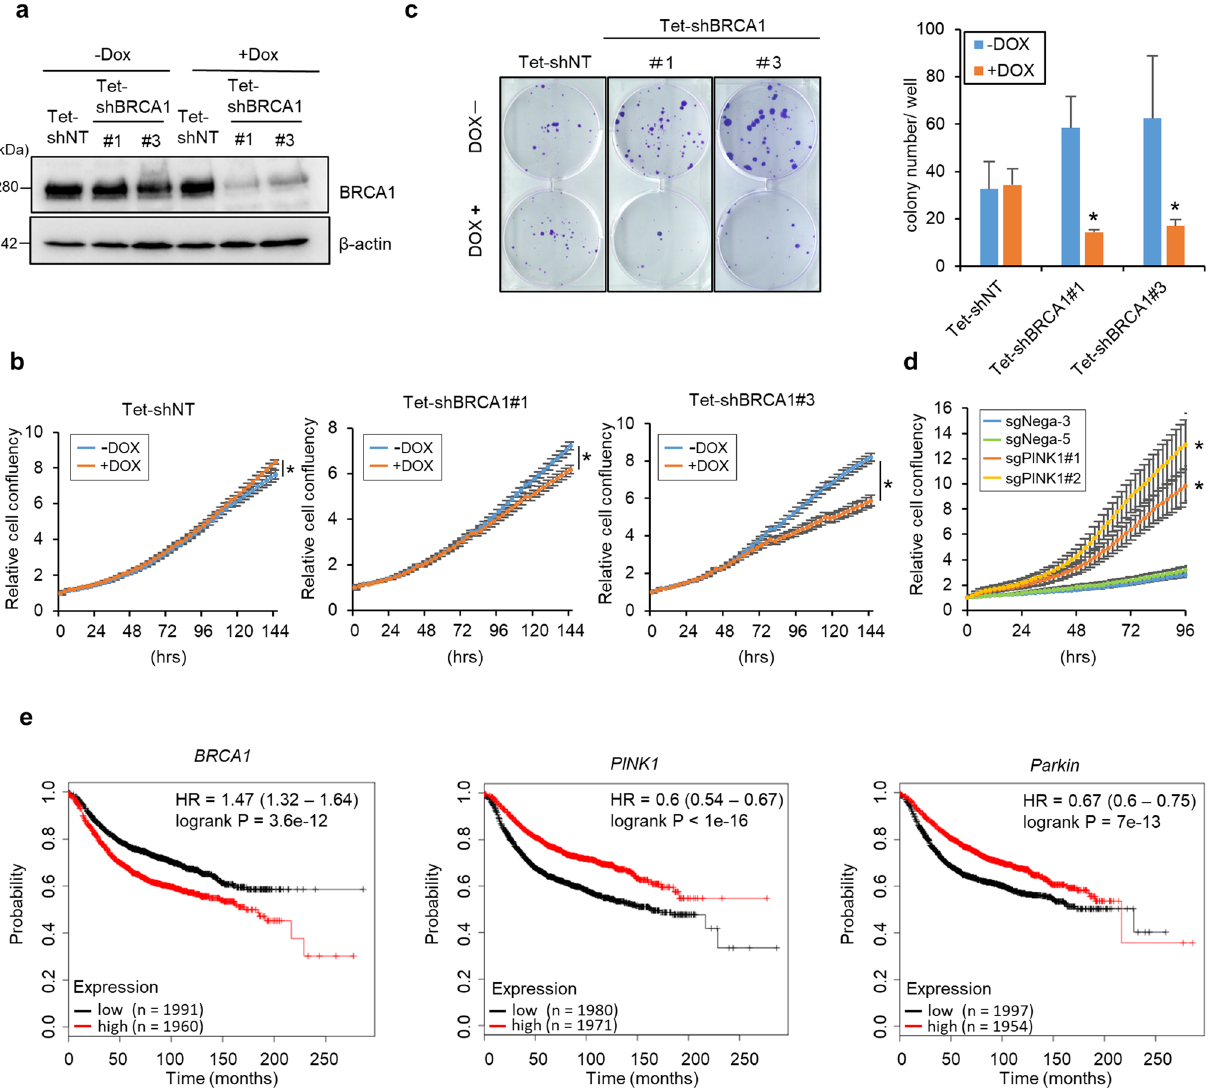
Figure 5. BRCA1 knockdown represses breast cancer cell growth and lower BRCA1 expression correlates with longer relapse-free survival rate. ( a ) MCF7 cells stably expressing Tet-shRNA vector against BRCA1 (Tet-shBRCA1) or control vector (Tet-shNT) were cultured with or without 0.1 μg/ml DOX for 48 h. BRCA1 knockdown efficiency was confirmed by Western blotting. ( b ) Growth of MCF7 cells expressing the Tet-shNT, Tet-shBRCA1 #1, or #3 vectors was assessed using the IncuCyte live-cell imaging system in the presence or absence of 0.1 μg/ml DOX for 4 days. n = 4, means ± S.D. * p < 0.05 versus -DOX. ( c ) Comparison of colony formation ability between MCF7 cells expressing Tet-shNT and Tet-shBRCA1. Cells were seeded in 6-well plates and cultured for 3 weeks in the presence or absence of 0.1 μg/ml DOX. Visualized colonies are shown in the left panel. Summarized colony numbers are shown in the right panel. Bar = means ± S.D. n = 3, * p < 0.05 versus -DOX. ( d ) The growth of PINK1 knockout MCF7 cells (sgPINK1#1, #2) or control cells (sgNega3, 5) was assessed using the IncuCyte live-cell imaging system. n = 5, means ± S.D. * p < 0.05 versus sgNega5. ( e ) Relapse- free survival rates of breast cancer patients were compared between high and low BRCA1, Parkin, or PINK1 expression in patients. Data are shown as Kaplan–Meier plots; graphs were generated using an online Kaplan– Meier